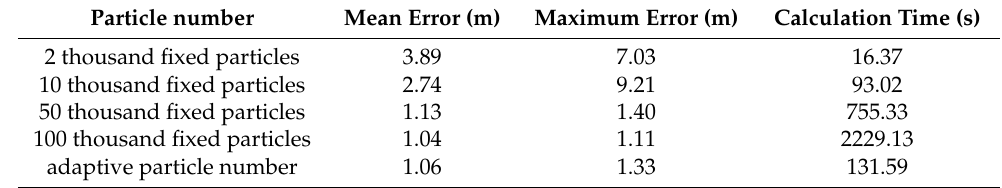
Table 7. Statistics of positioning errors with different particle numbers under experimental conditions.